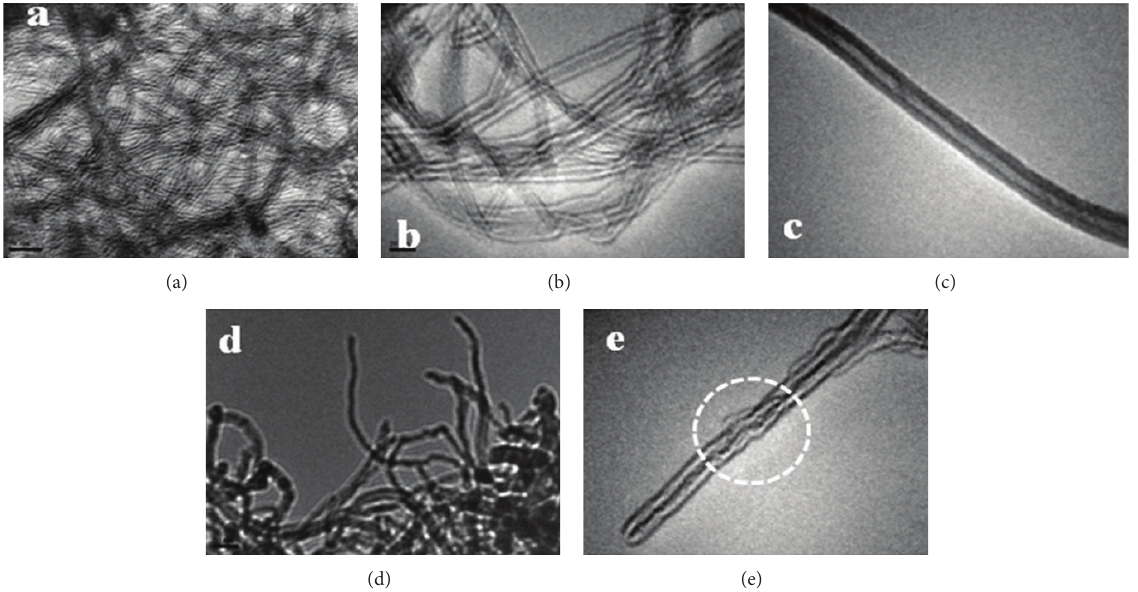
Figure 3: TEM micrographs of (a) pristine CNT; (b) and (c) McCNT; (d) and (e)